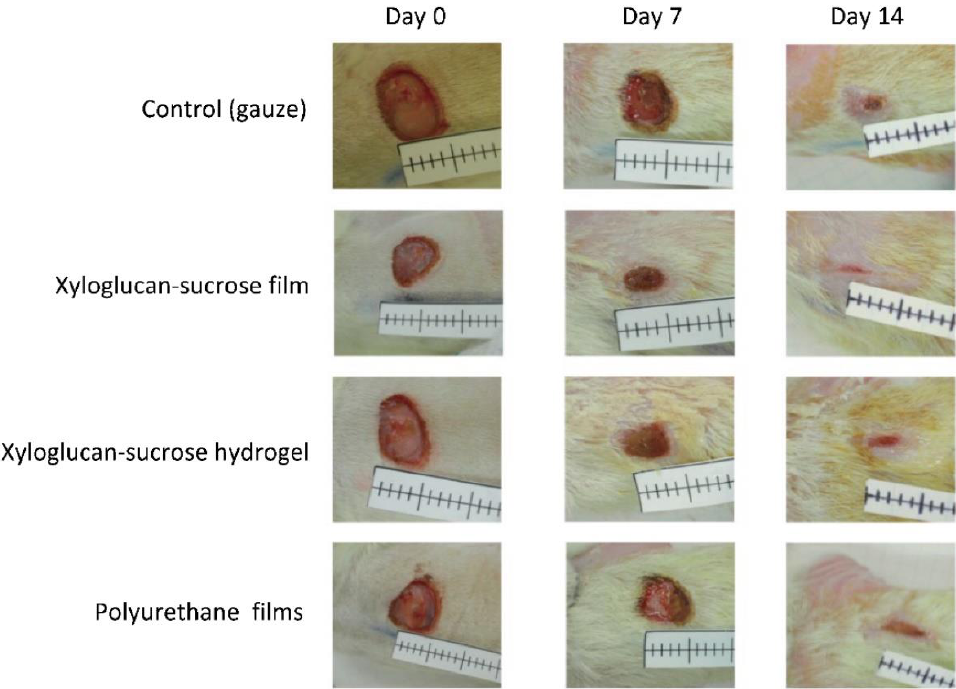
Figure 6. Wound healing processes in Wistar rats. XG–sucrose films resulted in faster healing when compared to a XG–sucrose hydrogel and a commercial polyurethane film. The materials were applied on wounds and covered with three sheets of gauze. The control was gauze alone. (Results reproduced from [92] with permission from the authors and The Pharmaceutical Society of Japan; copyright 2019.)